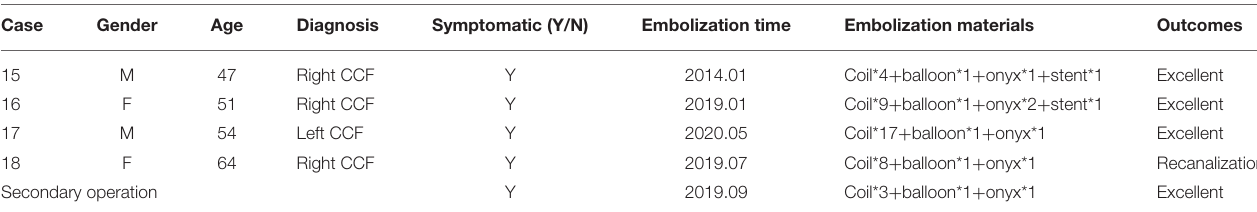
TABLE 2 | Summary of patients with direct CCFs, who underwent combined endovascular embolization. Case